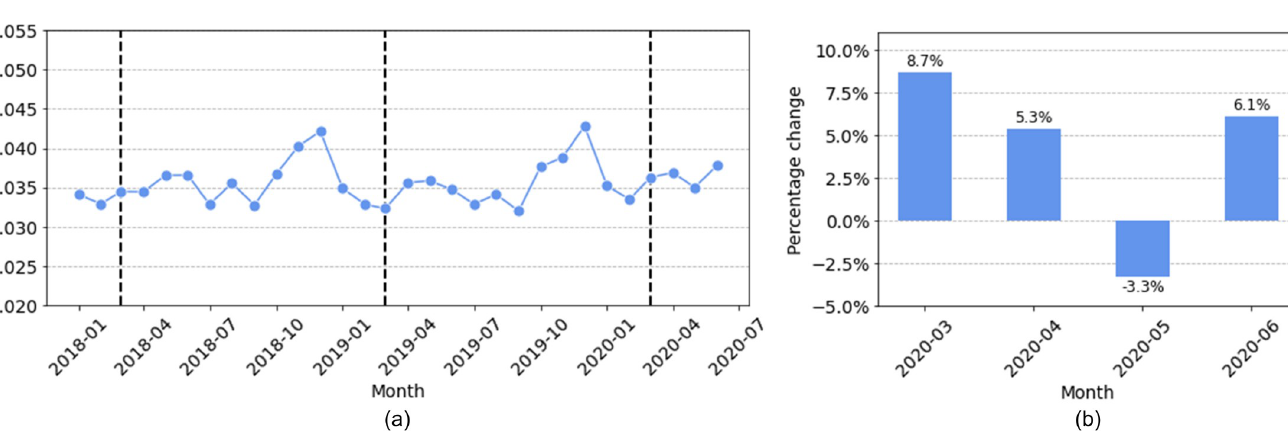
Fig 5. Total wine sales in thirteen states: (a) sales in ethanol per capita from January 2018 to June 2020 (the dashed lines indicate the month of March in 2018, 2019, and 2020); (b) sales changes in March, April, May, and June 2020 as compared with the average sales in the same months during 2018 and